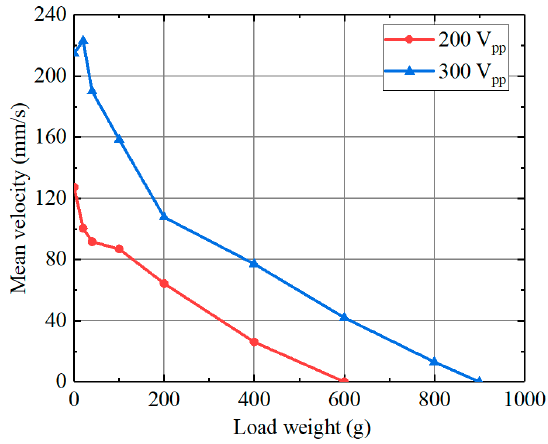
Figure 12. Load capacity of the proposed actuator prototype.